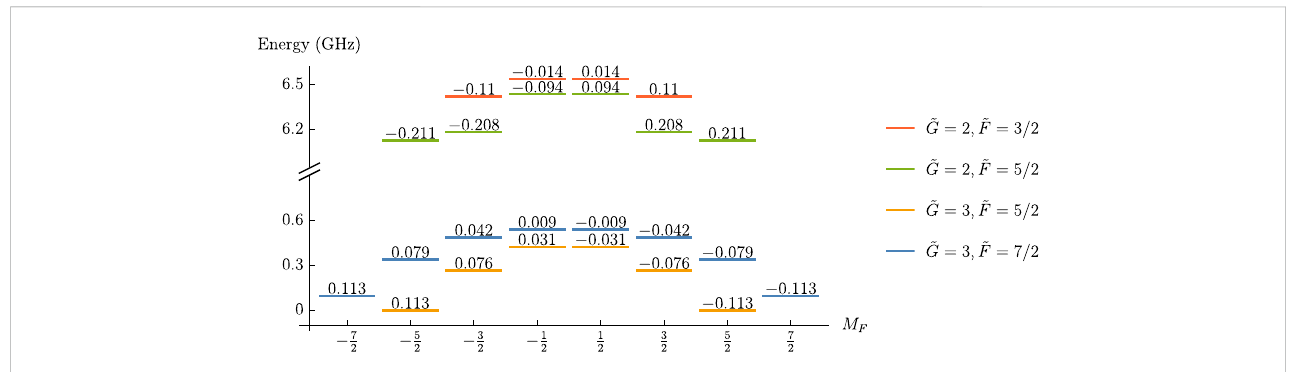
FIGURE 2 MQM energy shifts in the ground rotational state manifold of 173 YbF. The shifts are calculated at E = 18 kV/cm and given in units of W M M . States labeled with ~ G and ~ F are adiabatically linked to fi eld-free states with quantum numbers G and F